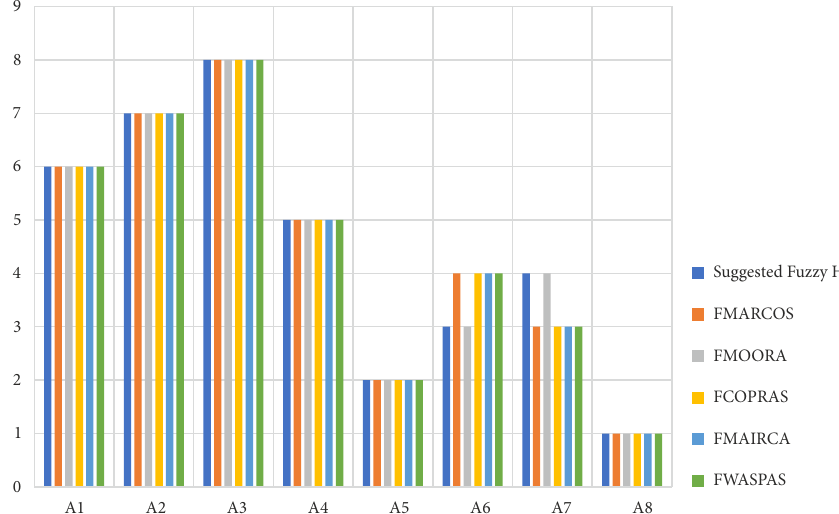
Figure 4. Ranking of the alternatives with different MCDM